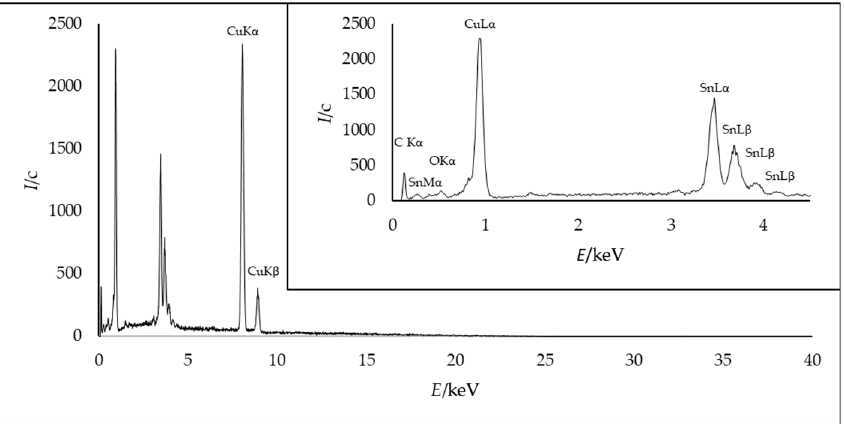
Figure 6. EDX area measurement of a Cu − Sn layer (0.5 A/dm 2 , 95 °C, 100 rpm, 10,800 s) with 85% mass fraction of copper.